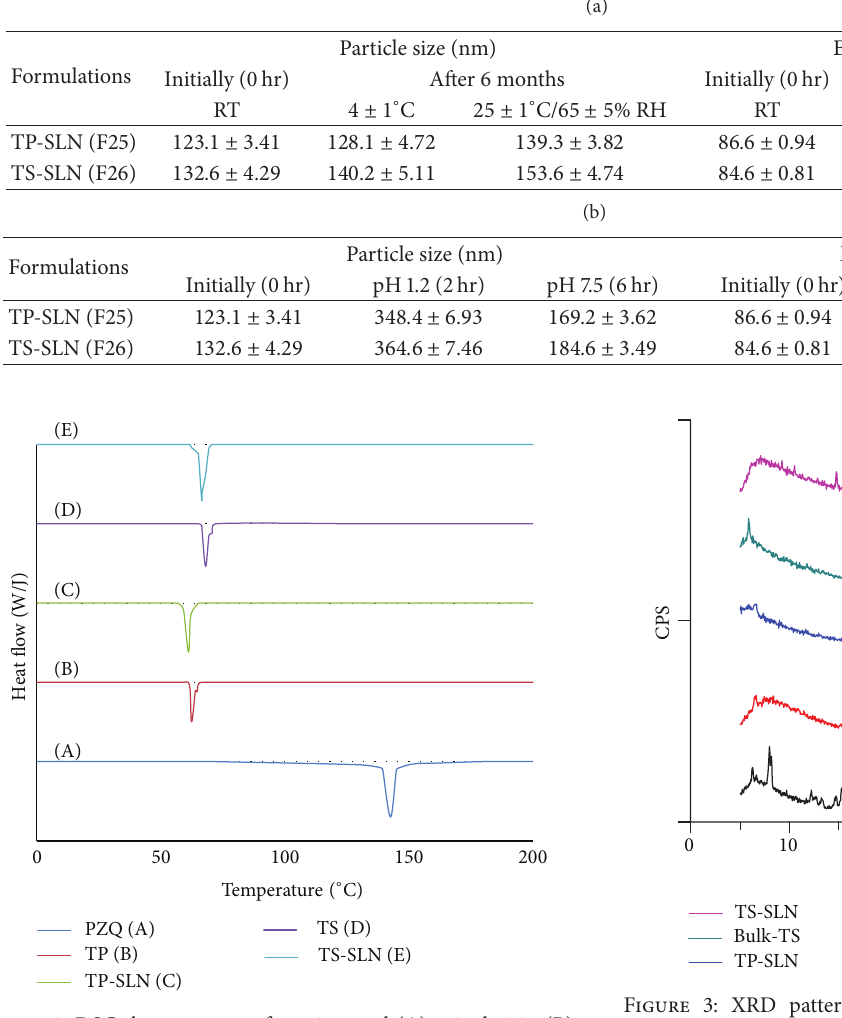
Figure 2: DSC thermograms of praziquantel (A), tripalmitin (B), praziquantel-loaded TP-SLN (C), tristearin (D), and praziquantel- loaded TS-SLN (E).